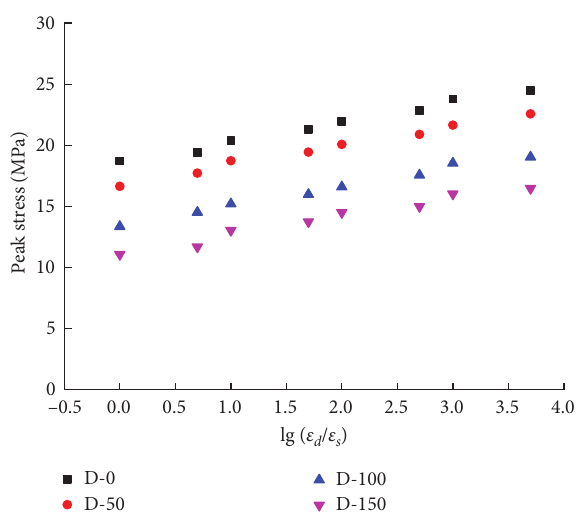
Figure 7: The effect of strain rate on the peak compressive stress.